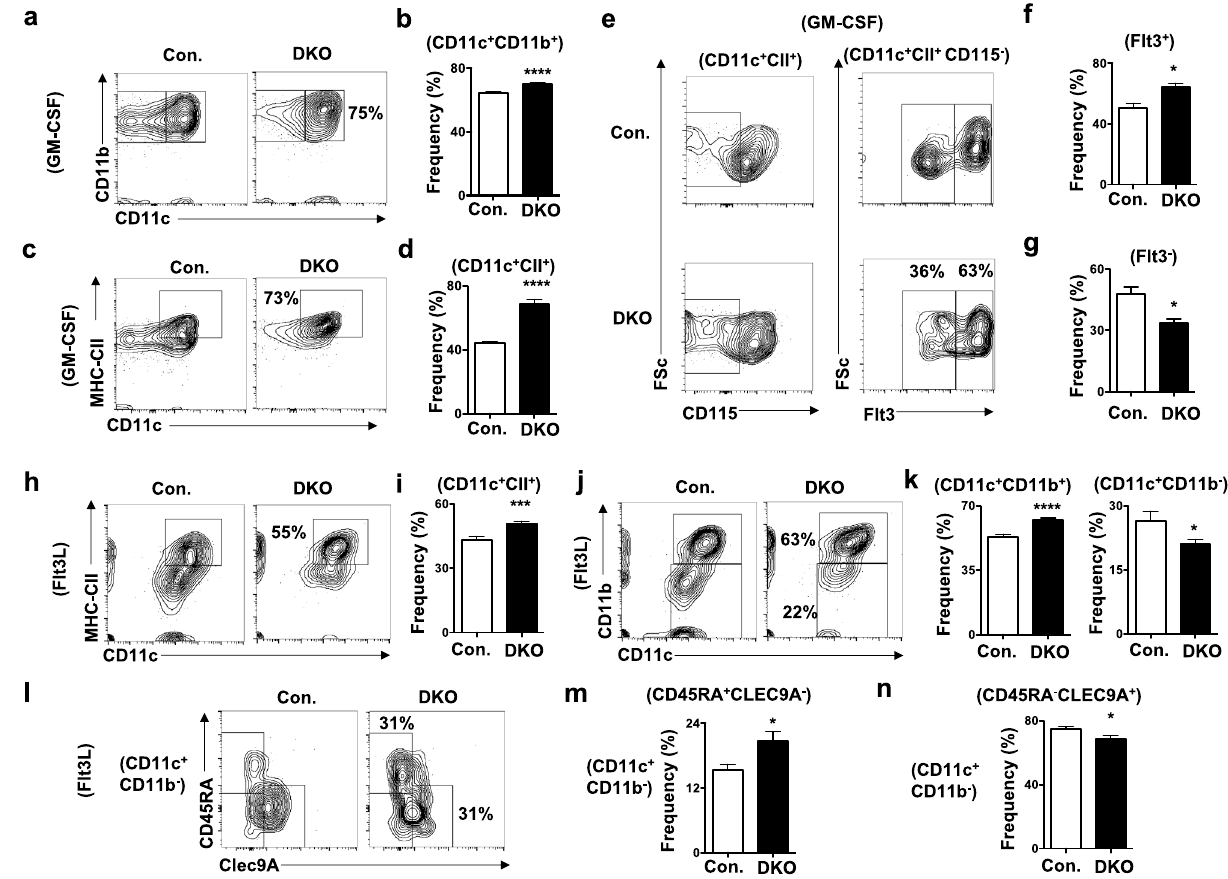
Figure 5. Deficiency of p85 subunits results in increased in-vitro DC differentiation. ( a ) FACS plots indicating frequencies of CD11b + CD11c + cells from the BM of DKO and control mice cultured in-vitro in the presence of GM-CSF for 7 days. Shown are the frequencies within the indicated gates. ( b ) Frequencies of CD11b + CD11c + cells from the BM of DKO and control mice cultured in-vitro in the presence of GM-CSF for 7 days (n = 3). Shown are the frequencies within the indicated gates. ( c ) FACS plots indicating frequencies of CD11c + CII high cells from the BM of DKO and control mice cultured in-vitro in the presence of GM-CSF for 7 days. Shown are the frequencies within the indicated gates. ( d ) Frequencies of CD11c + CII high cells from the BM of DKO and control mice cultured in-vitro in the presence of GM-CSF for 7 days (n = 3). Shown are the frequencies within the indicated gates. ( e ) FACS plots indicating frequencies of Flt3 + and Flt3 − cells from the BM of DKO and control mice cultured in-vitro in the presence of GM-CSF for 7 days (n = 3). Cells were pre-gated on CD11c + CII high CD115 − cells. Shown are the frequencies within the indicated gates. ( f ) Frequencies of Flt3 + cells within CD11c + CII high CD115 − fraction from the BM of DKO and control mice cultured in-vitro in the presence of GM-CSF for 7 days (n = 3). Shown are the frequencies within the indicated gates. ( g ) Frequencies of Flt3 − cells within CD11c + CII high CD115 − fraction from the BM of DKO and control mice cultured in-vitro in the presence of GM-CSF for 7 days (n = 3). Shown are the frequencies within the indicated gates. ( h ) FACS plots indicating frequencies of CD11c + CII + cells from the BM of DKO and control mice cultured in-vitro in the presence of Flt3L for 14 days. Shown are the frequencies within the indicated gates. ( i ) Frequencies of CD11c + CII + cells from the BM of DKO and control mice cultured in-vitro in the presence of Flt3L for 14 days (n = 3). Shown are the frequencies within the indicated gates. ( j ) FACS plots indicating frequencies of CD11c + CD11b + cells from the BM of DKO and control mice cultured in-vitro in the presence of Flt3L for 14 days. Shown are the frequencies within the indicated gates. ( k ) Frequencies of CD11c + CD11b + (left) and CD11c + CD11b − (right) cells from the BM of DKO and control mice cultured in-vitro in the presence of Flt3L for 14 days (n = 3). Shown are the frequencies within the indicated gates. ( l ) FACS plots indicating frequencies of CD45RA + Clec9A − and CD45RA − Clec9A + cells from the BM of DKO and control mice cultured in-vitro in the presence of Flt3L for 14 days. Cells were pre-gated on CD11c + CD11b − cells. Shown are the frequencies within the indicated gates. ( m ) Frequencies of CD45RA + Clec9A − cells within CD11c + CD11b − fraction from the BM of DKO and control mice cultured in-vitro in the presence of Flt3L for 14 days (n = 3). Shown are the frequencies within the indicated gates. ( n ) Frequencies of CD45RA − Clec9A + cells within CD11c + CD11b − fraction from the BM of DKO and control mice cultured in-vitro in the presence of Flt3L for 14 days (n = 3). Shown are the frequencies within the indicated gates. Data represent mean and s.e.m. Two-tailed student’s t tests were used to assess statistical significance (* P < 0.05, ** P < 0.01, *** < 0.001, **** < 0.0001, n.s. P >